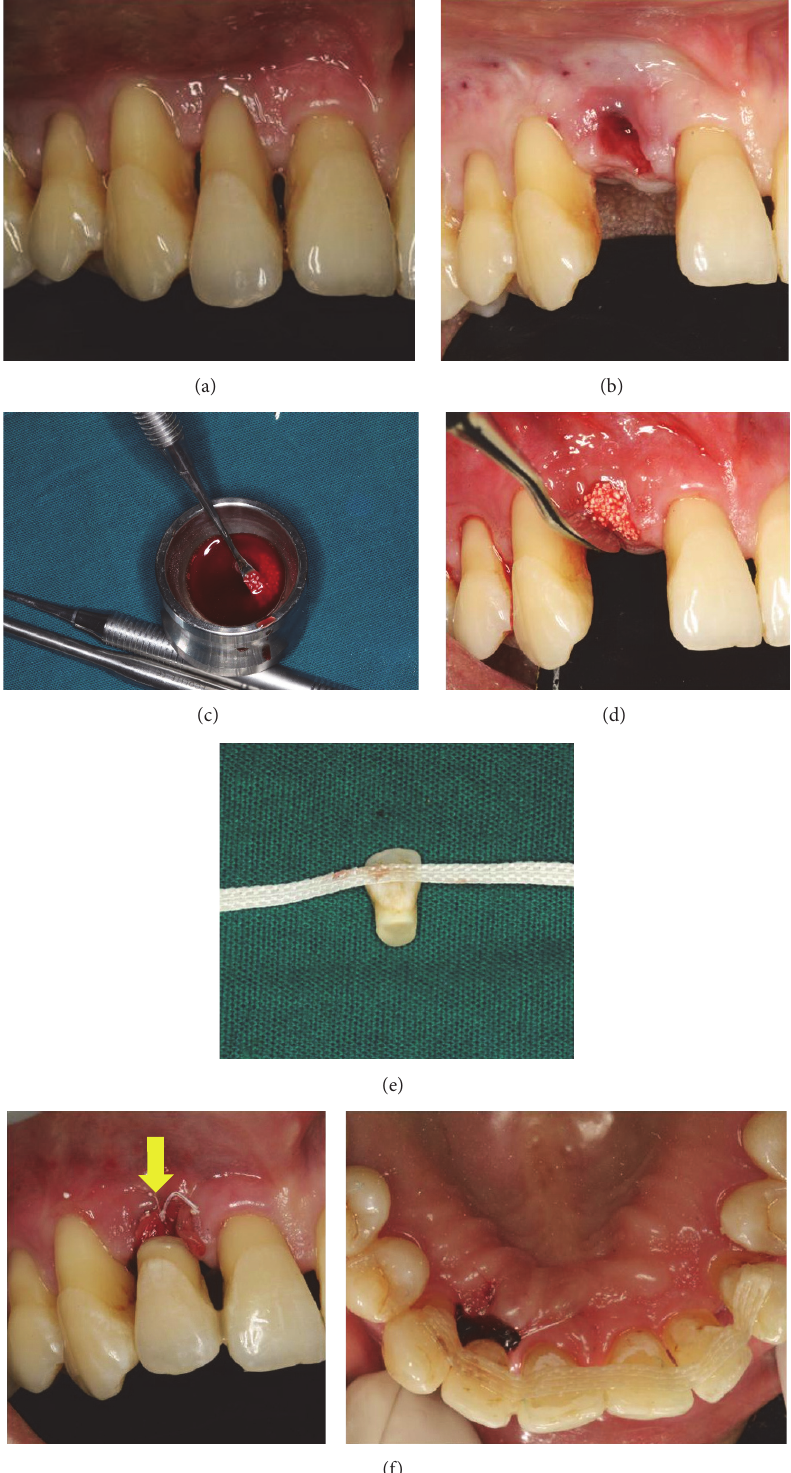
Figure 2: (a) Preoperative. (b) Atraumatic extraction. (c) Preparation of sticky bone. (d) Socket preservation. (e) Ribbond attached to natural crown. (f) Immediate postoperative NTP with respect to